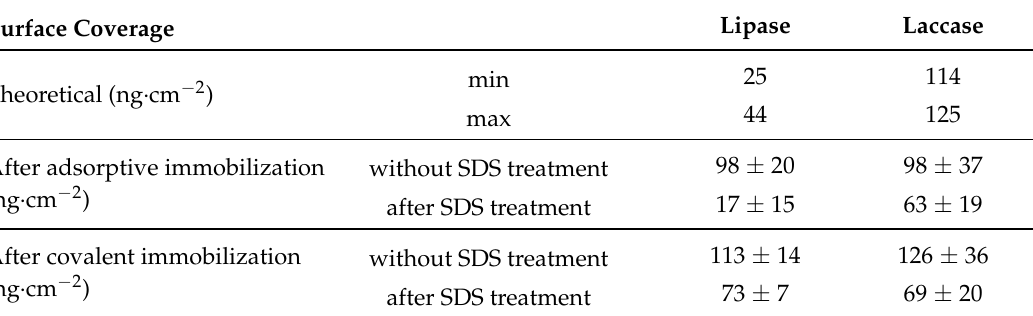
Determined surface coverage of lipase and laccase after adsorptive and covalent immobilization and calculated theoretical minimum and maximum coverages of the enzymes on the BT surface. Additionally, the effect of SDS treatment after enzyme immobilization for each immobilization technique on surface coverage is presented. Immobilization conditions were described in Table 4. n =